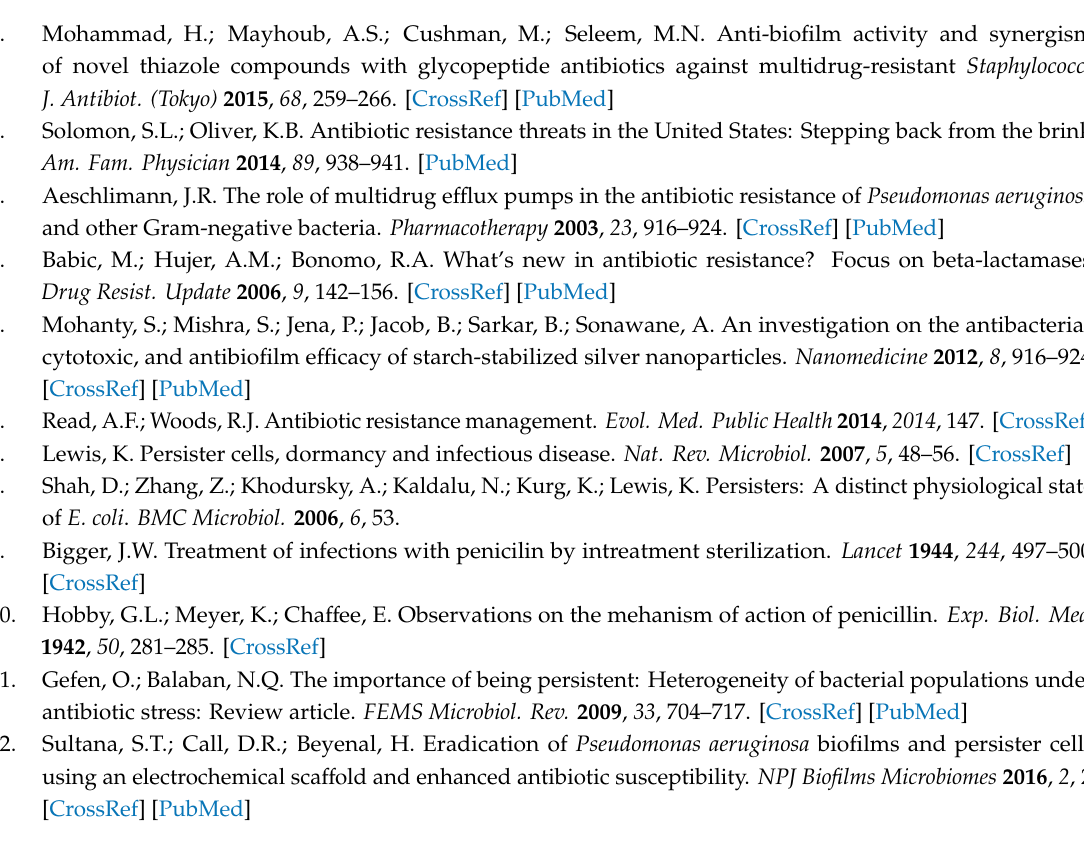
standard deviation, Figure S3: Histograms displaying heterogeneities quantified in the estimated biopolymer brush thickness resulting from fitting the steric model (Equation (1)) to the approach distance-force data for E. coli untreated (A and D), treated at MIC (B and E) and persister (C and F) cells for Strains A5 and A9, respectively. Solid lines are the normal distributions fits to the data. SD is standard deviation, Figure S4: Histograms displaying heterogeneities quantified in the estimated biopolymer brush grafting density resulting from fitting the steric model (Equation (1)) to the approach distance-force data for E. coli untreated (A and D), treated at MIC (B and E) and persister (C and F) cells for Strains A5 and A9, respectively. Solid lines are the normal distributions fits to the data. SD is standard deviation, Figure S5: Histograms displaying heterogeneities quantified in the estimated Young’s modulus of elasticity resulting from fitting the Hertz model (Equation (2)) to the approach indentation-force data for E. coli untreated (A and D), treated at MIC (B and E) and persister (C and F) cells for Strains A5 and A9, respectively. Solid lines are the normal distributions fits to the data. SD is standard deviation, Figure S6: Scatter plots between bacterial polymer brush thickness and A) adhesion force and B) root mean square (RMS) roughness. Scatter plots between grafting density and C) adhesion force, D) root mean square (RMS) roughness, E) polymer brush thickness and F) elasticity, Figure S7: Scatter plots of bacterial surface area (SA) versus A) adhesion force, B) elasticity, and C) grafting density. D) Bacterial surface root-mean-square (RMS) roughness versus adhesion force. Data used were taken from both Strains, and Figure S8: Representative retraction curves of untreated cells, cells treated at MIC (resistant) and cells treated at 20 × MIC (persisters) collected A) for Strain A5 and B) for Strain A9 in